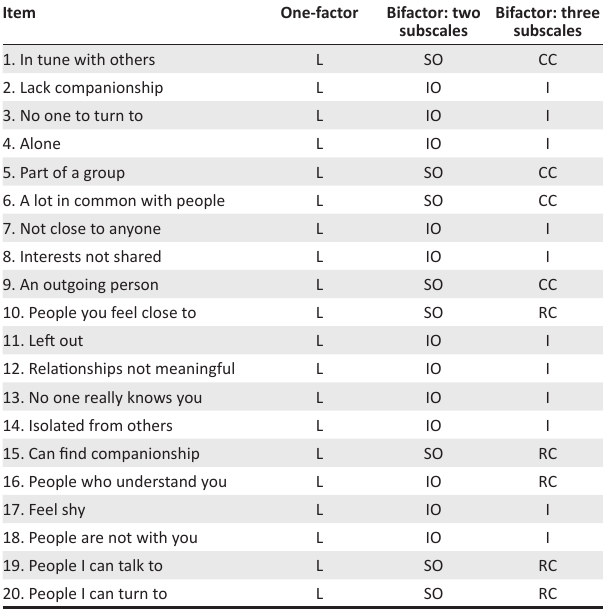
Bifactor: three subscales subscales